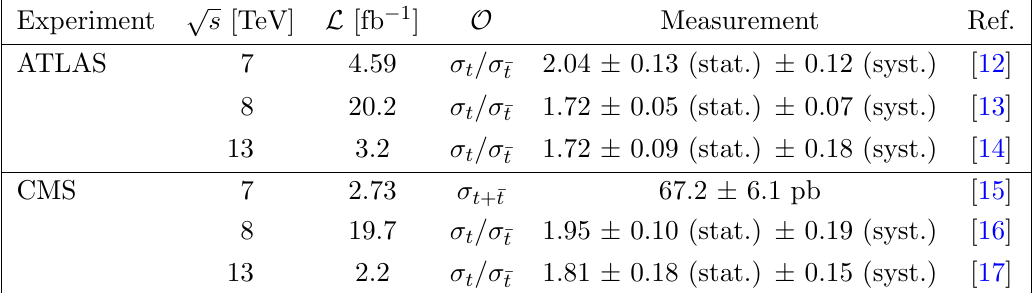
Table 1 . Measurements of total t -channel single top-quark and top-antiquark cross sections and their ratio analysed in this work. For each of them we indicate the experiment, the centre-of- p mass energy, s , the integrated luminosity, L , the measured observable, O , its value (stat. and syst. denote statistical and systematic uncertainties), and its